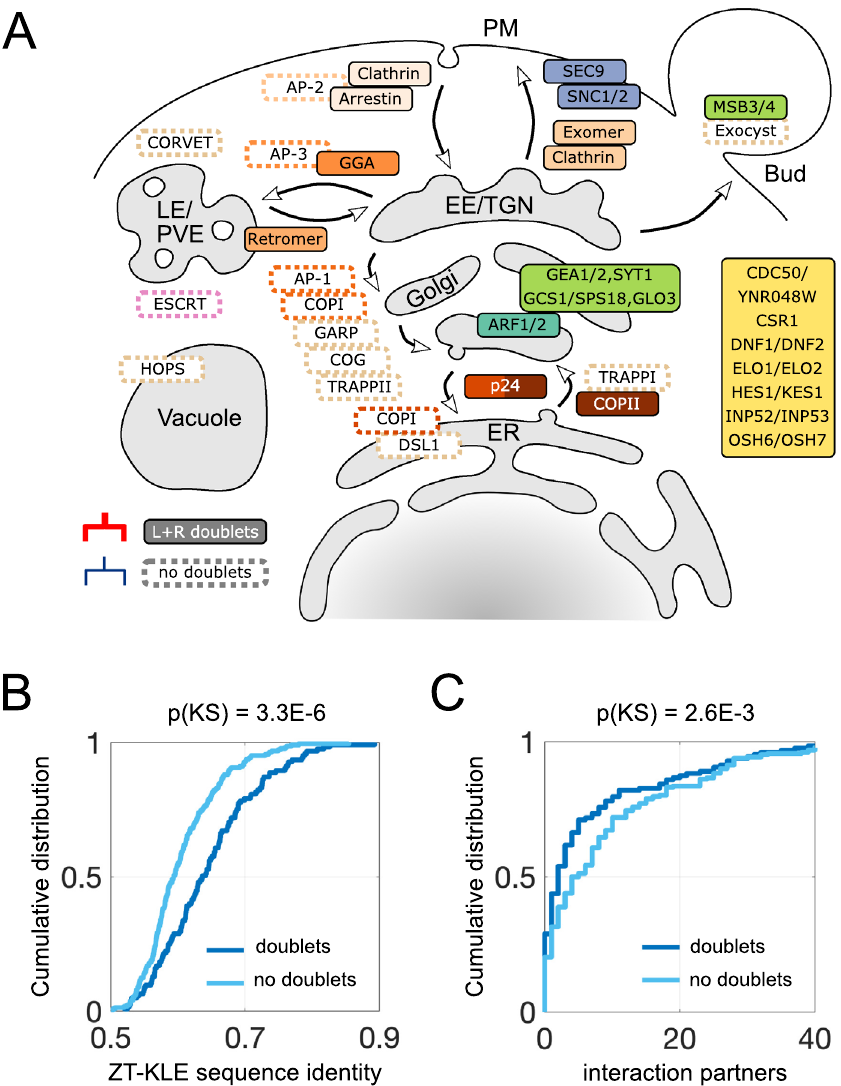
Figure 3. Landscape of vesicle traffic evolution in the WGD clade. ( A ) We show the site of action of proteins within the yeast vesicle traffic network. Filled boxes are proteins or complexes corresponding to genes present as L+R doublets. Dotted boxes show selected complexes for which the majority of proteins are present as singletons: the COPI coat and AP adaptors, tethers, and ESCRT. ( B,C ) We separate the 360 ancestral vesicle traffic doublets into two groups: those that are present as doublets in at least one species (dark blue) and those that are not doublets in any species (light blue). For each group, the curves show the cumulative distribution of two quantities. P-value calculations are described in the main text and “Methods”. ( B ) Inferred sequence identity between ZT and KLE orthologs (in Z. rouxii and K. lactis ) corresponding to each ancestral doublet. ( C ) Number of physical interaction partners of the protein corresponding to each ancestral